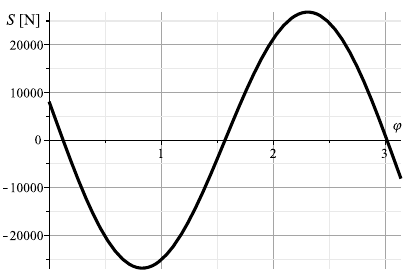
Figure 4: Rotating half circular two-layer beam.